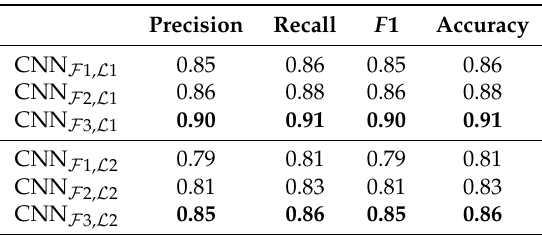
Table 3. Segment classification performance for combinations of feature and label sets averaged over an 8-fold